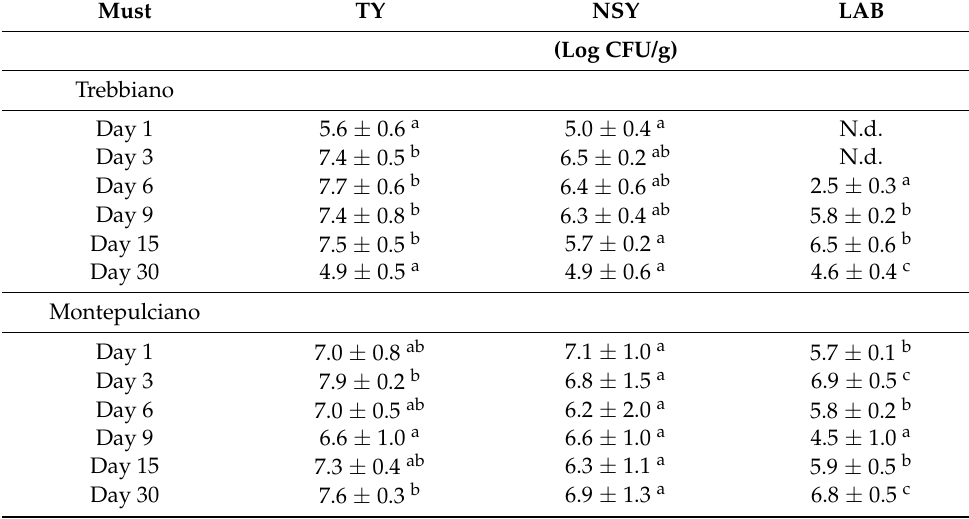
Figure 1. Evolution of spontaneous wine fermentations of Trebbiano (yellow dots) and Montepulciano (bordeaux squares) grapes measured as density (full line; g/cm 3 ) and temperature (dashed line; °C). Error bars indicated the standard deviation of the replicates ( n = 3). Table 2. Microbiological characteristics of samples collected in six different points of fermentation in two wines (Trebbiano and Montepulciano) of Abruzzo. Abbreviation: TY, Total Yeast; NSY, Non- Saccharomyces yeast; LAB, lactic acid bacteria, N.d., not detected. Plate counts are expressed as the mean ± SD ( n = 3). For each column, microbial count, and values with a, b, and c superscripts are significantly different ( p <